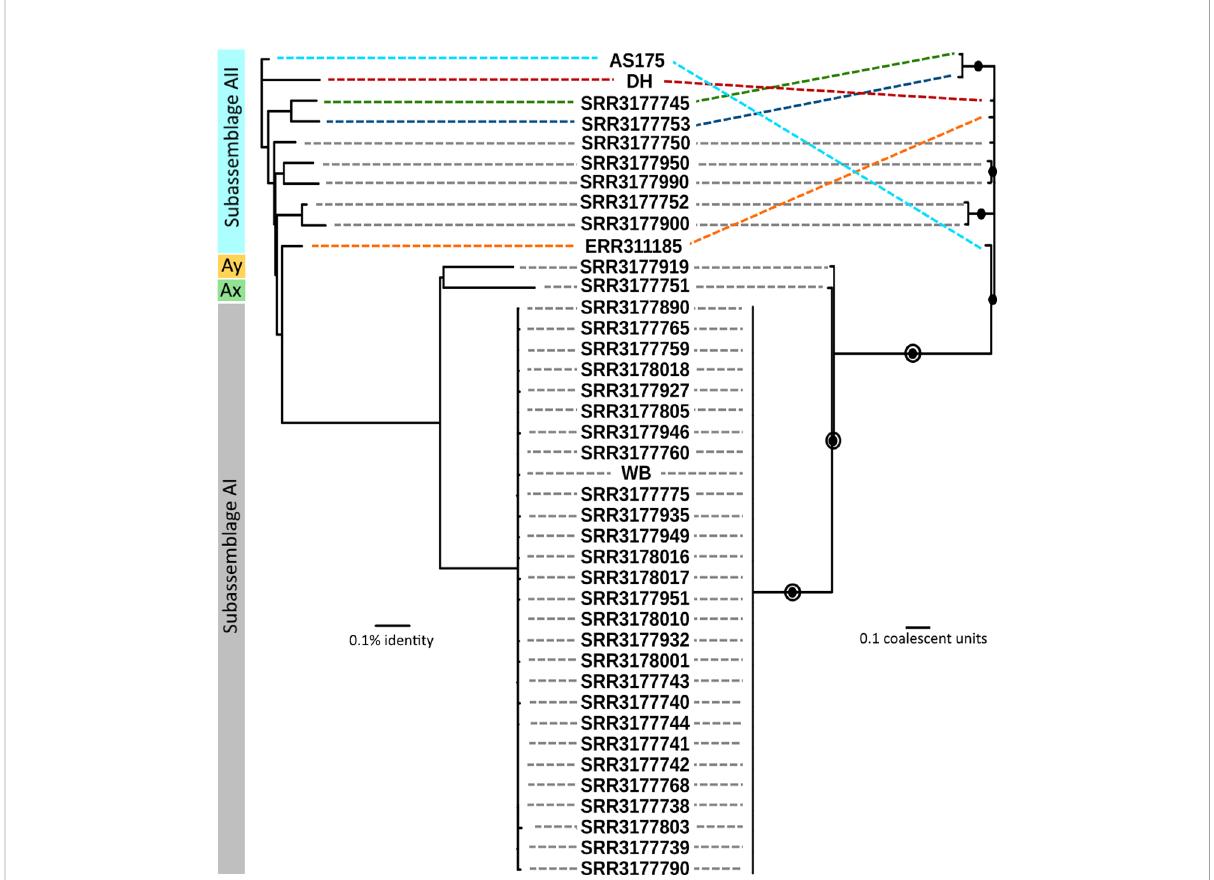
FIGURE 2 Comparison of genomic relatedness using ANI and multilocus coalescent estimations. Left side: ANI tree constructed from pairwise comparisons of draft genomes. Right side: Coalescent tree estimated by ASTRAL-III using gene trees from all pangenome loci. Filled circles indicate nodes with greater than 95% bootstrap support. Open circles indicate nodes with greater than 95% support in the set of trees estimated by STACEY. Grey dashed lines indicate concordant placement of a genome on opposing trees. Colored dashed lines indicate speci fi c genomes which had differing